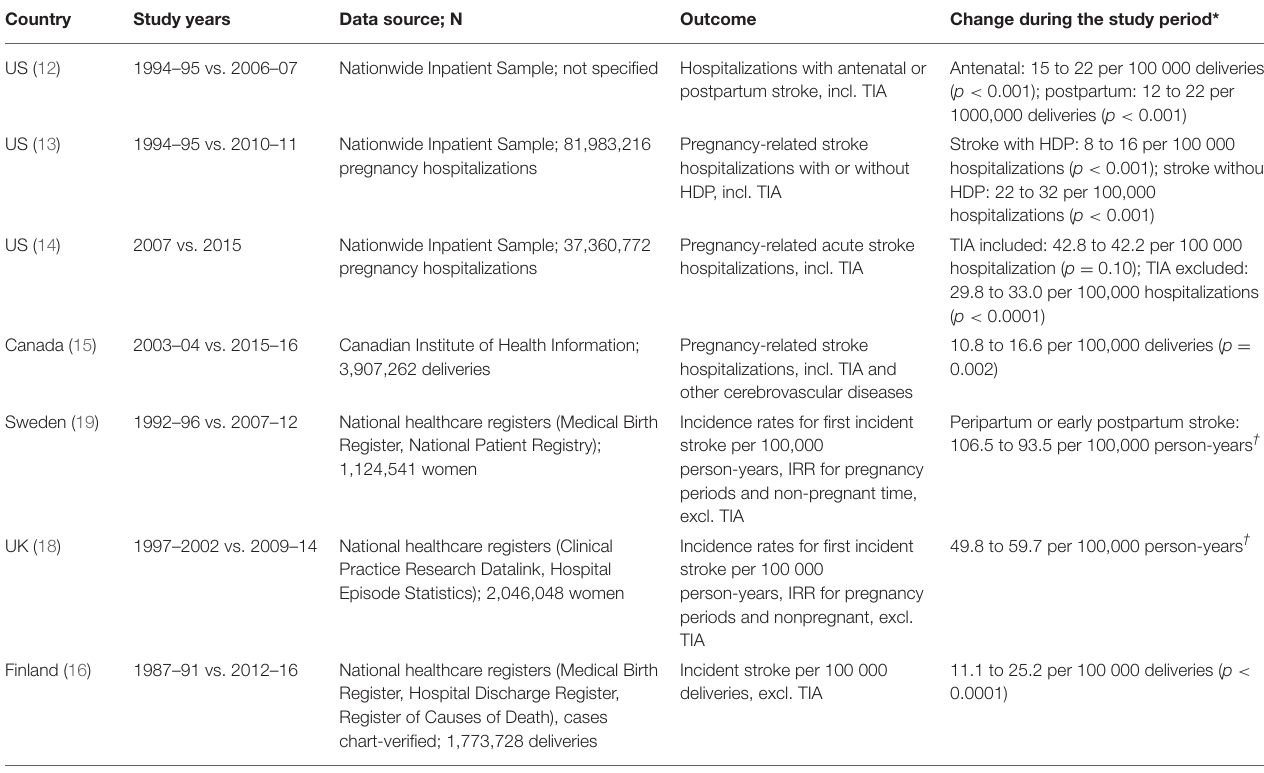
TABLE 1 | Studies reporting long-term incidence trends of pregnancy-associated stroke.